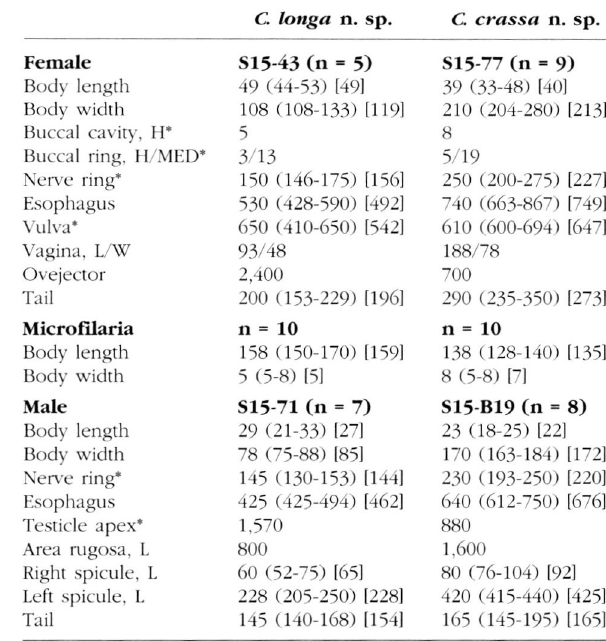
Table 1. - Measurements of adults and microfilariae of species of Cercopithifilaria found in sika deer.